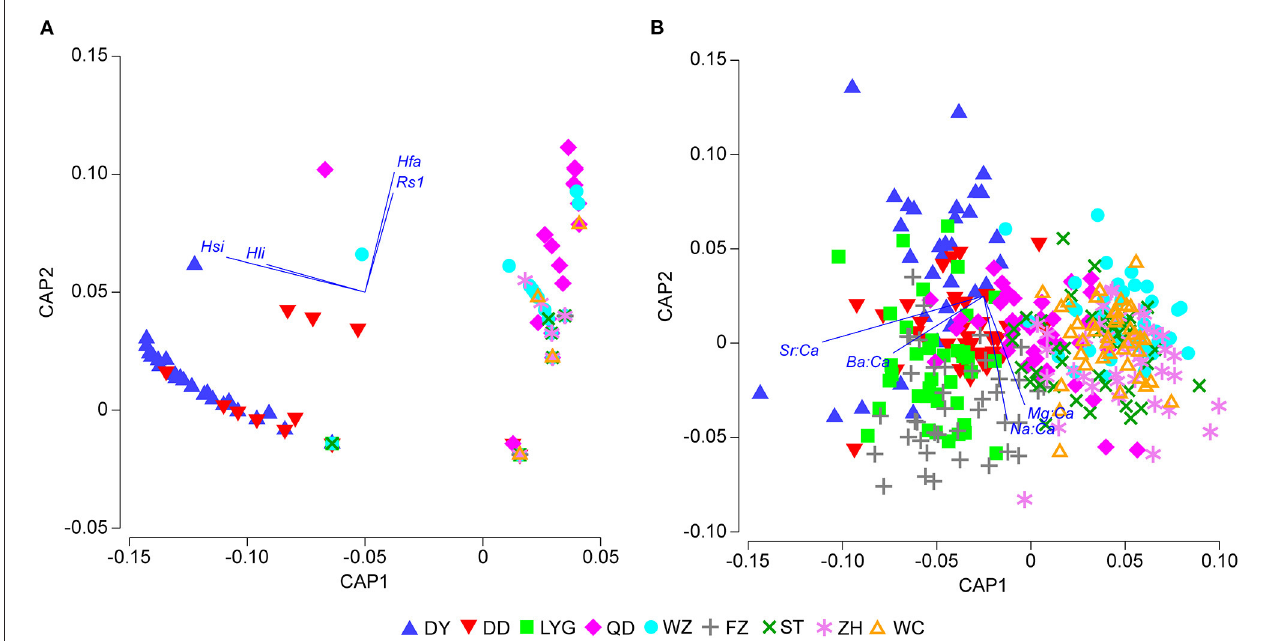
FIGURE 3 | Canonical analysis of principal coordinates (CAP) biplot of spinyhead croaker C. lucidus from Chinese coastal waters. (A) Parasite infracommunities based on Bray–Curtis dissimilarity (dummy variable value = 1) of square-root-transformed parasite abundance data; (B) otolith chemistry based on Euclidean distance dissimilarity of square-root-transformed otolith nucleus elemental concentration data. Vectors represent Pearson’s correlations of individual parasite species or otolith elemental ratios with the CAP axes ( r > 0.3), including Hsi, Hysterothylacium sinense ; Hli, H. liparis ; Rs1, Raphidascaris sp. 1; and Hfa, H. fabri . Abbreviations of estuary codes are shown in Table 1 . For interpretation of the color references in this figure legend, the reader is referred to the web version of this